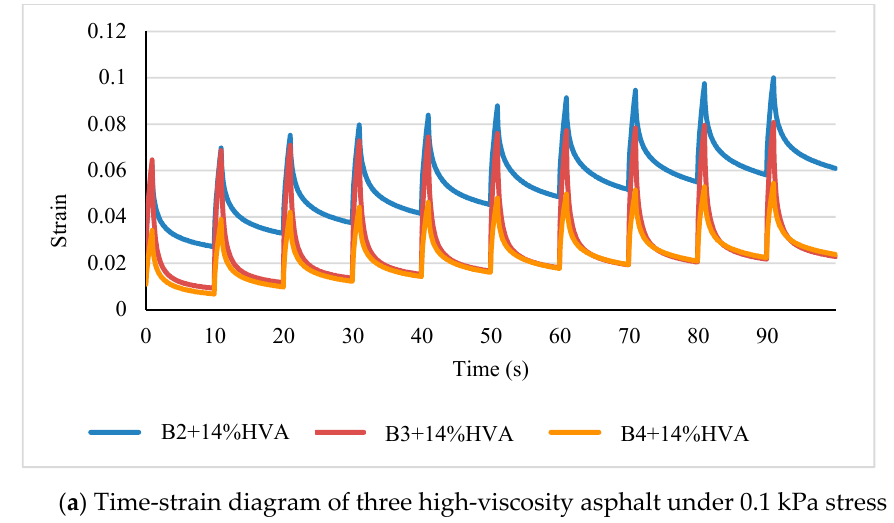
Figure 7. MSCR test results of matrix asphalt.